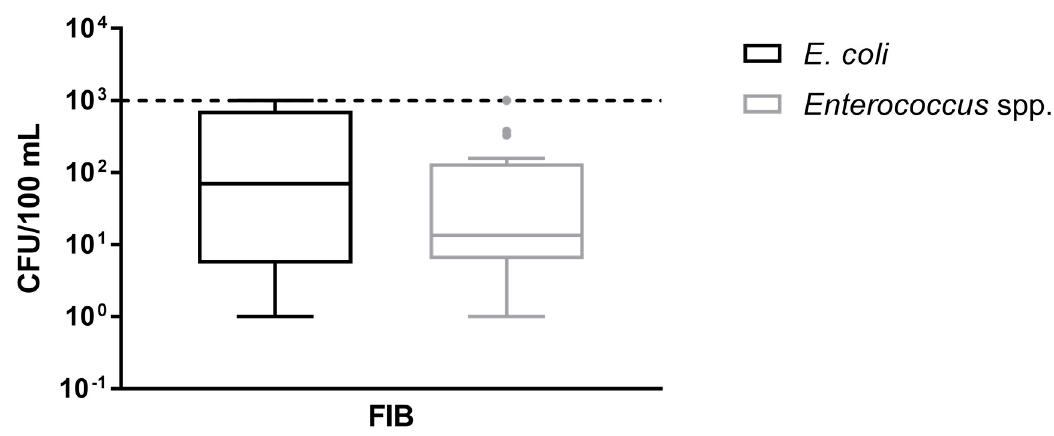
Figure 1. Fecal indicator bacteria (FIB) concentrations measured in positive samples from 2016 sampling. Upper limit of quantification shown by dotted line was 1000/100 mL.